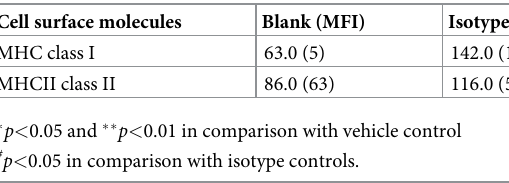
Table 1. Effects of F3 on the expression of MHC class I and class II in 4T1 cells. Cell surface molecules